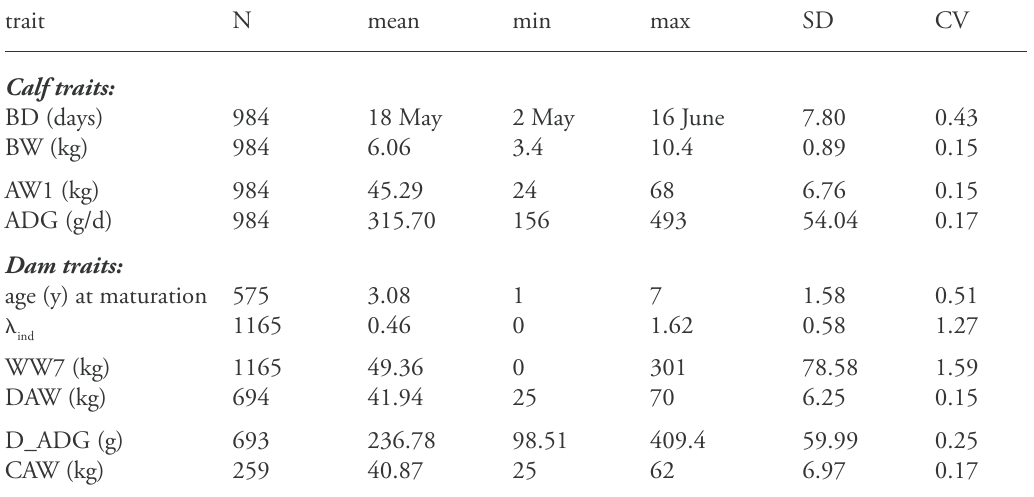
BW = birth weight, AW1 = calf autumn weight, BD = birth date, ADG = average daily gain, l vidual fitness, WW7 = cumulative weaning weight of calves over seven years, DAW = dam’s weight in her first autumn, D_ADG = average calf daily gain of a female, CAW = the autumn weight of dam’s first calf. N = number of records, SD = standard deviation, and CV = coefficient of